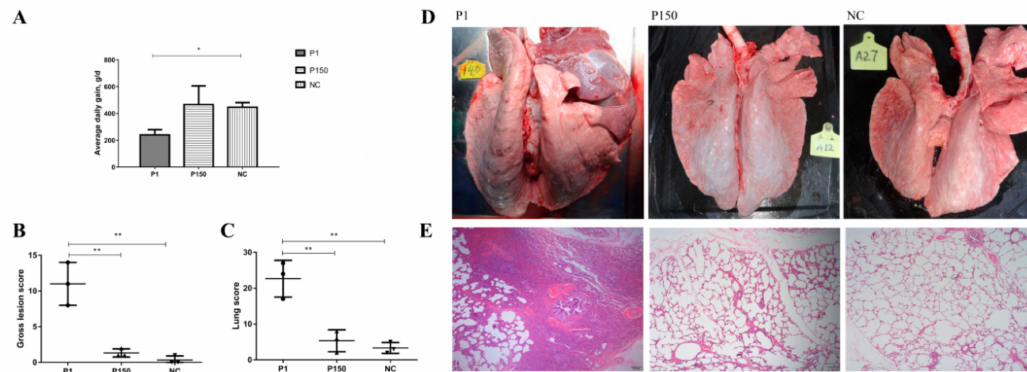
Figure 2. Average daily gain and pathological examination of calves of the three groups. ( A ) Average daily gain. ( B ) and ( C ) Evaluation of pathological severity with systemic gross score and lung score of the calves infected with either virulent M. bovis P1 (P1) or attenuated P150 strains (P150) with mock-infection control group (NC). ( D ) Gross lung lesion in the calves infected with M. bovis strains P1 and P150 compared with NC. ( E ) Histopathological images of lung tissues from the experimental calves stained by H&E. The lung tissues from the calves exhibited thickened alveolar septa, obliterated and collapsed (atelectatic) or dilated (emphysema) alveoli, shedding of bronchiolar epithelium and lymphohistiocytic infiltrates in P1 group, in contrast to intact architecture of alveoli and clear alveolar spaces in P150 and NC groups. Magnification = 40 ×